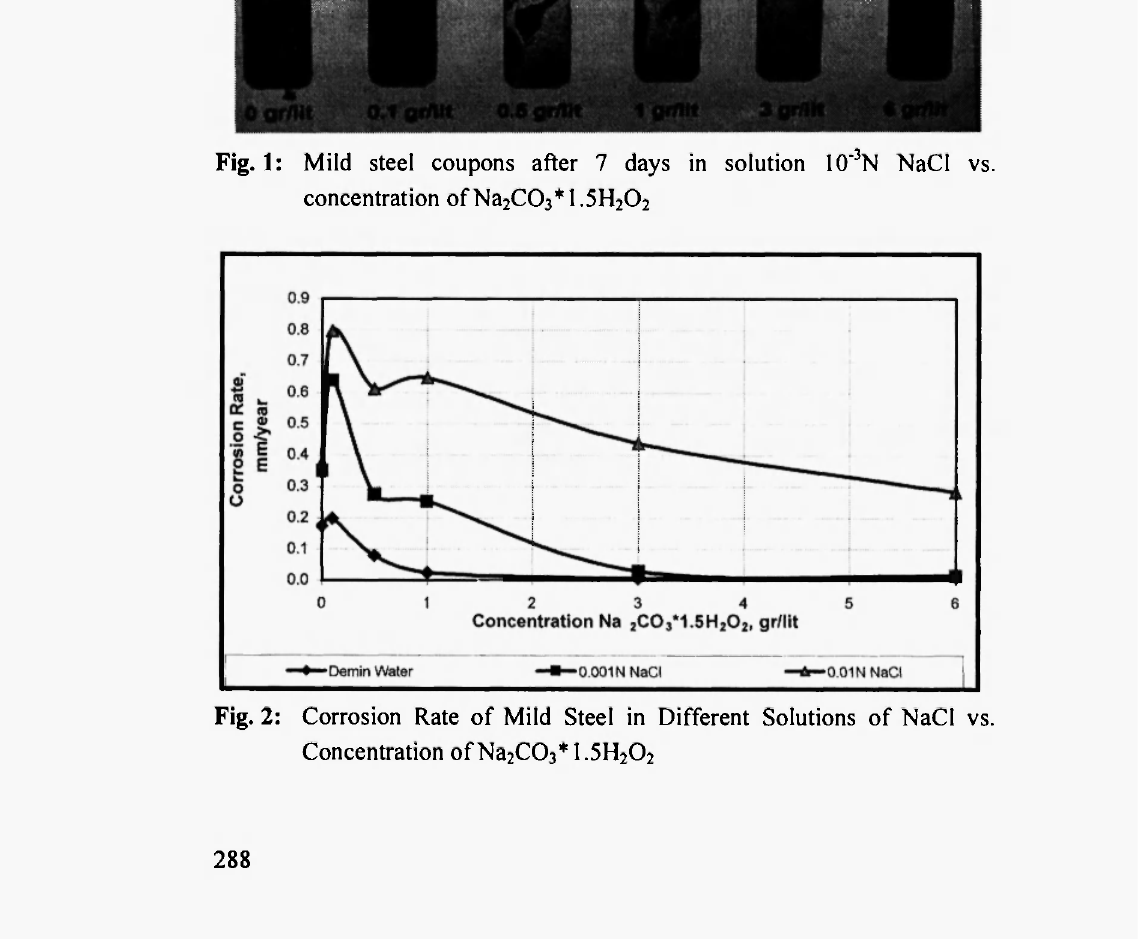
Fig. 2: Corrosion Rate of Mild Steel in Different Solutions of NaCl